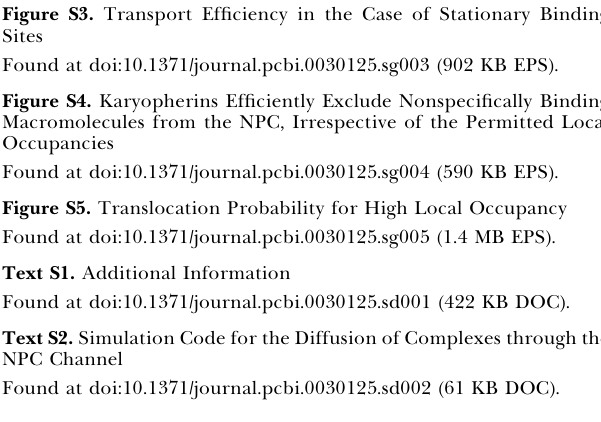
Figure S1. Several Binding Sites on a Single FG-Repeat Region Result in an Effective Potential Found at doi:10.1371/journal.pcbi.0030125.sg001 (492 KB EPS). Figure S2. Array of Discrete Bindings Sites Found at doi:10.1371/journal.pcbi.0030125.sg002 (381 KB EPS). Figure S3. Transport Efficiency in the Case of Stationary Binding Sites Found at doi:10.1371/journal.pcbi.0030125.sg003 (902 KB EPS). Figure S4. Karyopherins Efficiently Exclude Nonspecifically Binding Macromolecules from the NPC, Irrespective of the Permitted Local Occupancies Found at doi:10.1371/journal.pcbi.0030125.sg004 (590 KB EPS). Figure S5. Translocation Probability for High Local Occupancy Found at doi:10.1371/journal.pcbi.0030125.sg005 (1.4 MB EPS). Text S1. Additional Information Found at doi:10.1371/journal.pcbi.0030125.sd001 (422 KB DOC). Text S2. Simulation Code for the Diffusion of Complexes through the NPC Channel Found at doi:10.1371/journal.pcbi.0030125.sd002 (61 KB